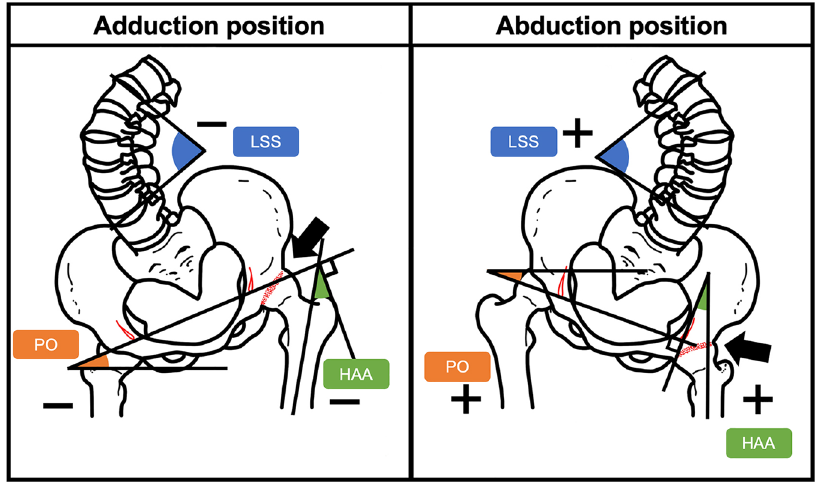
Figure 1. Illustration of a standing anterior–posterior radiograph showing adduction and abduction hip deformities on the left side. LS , lumbar scoliosis; PO , pelvic obliquity; HAA , hip adduction